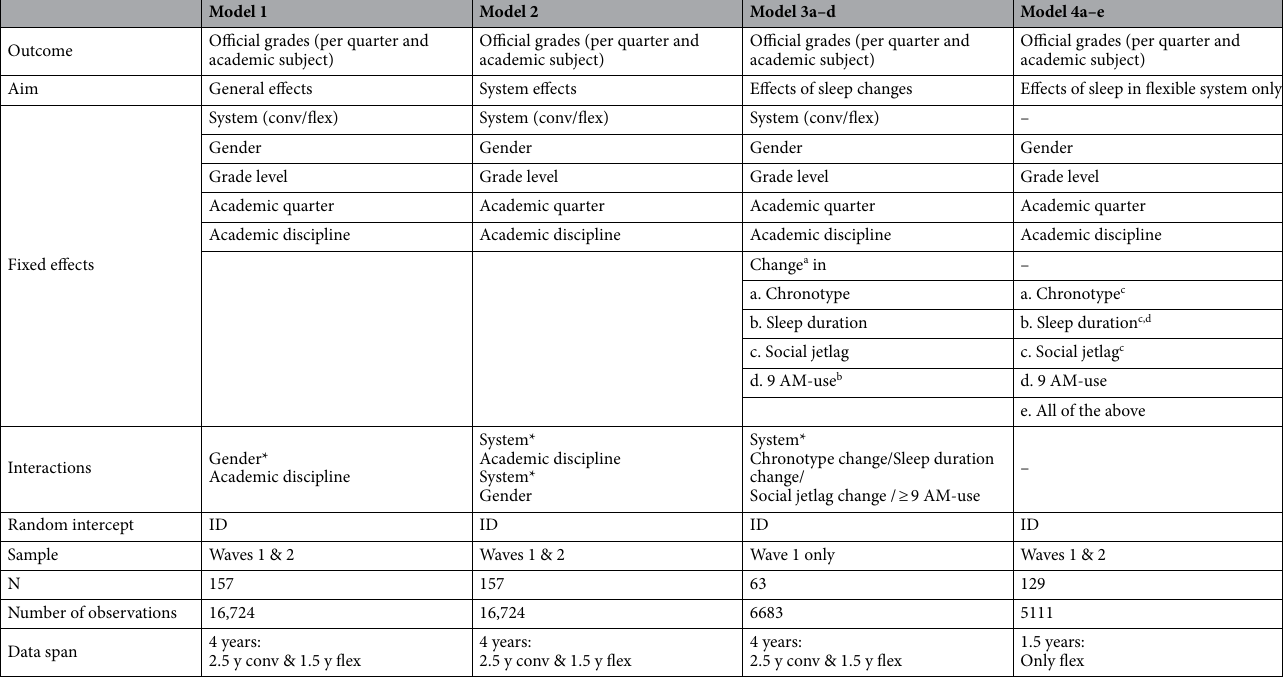
Table 1. Overview of linear mixed model analyses on official, quarterly grades. Four different models (and several model variations) were calculated, each with a different aim and including appropriate predictors (fixed effects) and interaction terms. All models included ID as a random intercept to incorporate random inter-individual differences. conv conventional school start system, flex flexible school start system. a Change refers to the absolute difference between the respective variable at t1 minus t0 (baseline). Positive values indicate higher numbers at t1. b Since the exact frequency of 9 AM-starts during baseline (t0) is not known, 9 AM-use was added as an absolute value rather than the change from t0 to t1. Students attended school at ≥ 9 AM at a median of 1 day per week in the conventional system. c From t2 if possible, else from t1. d Duration